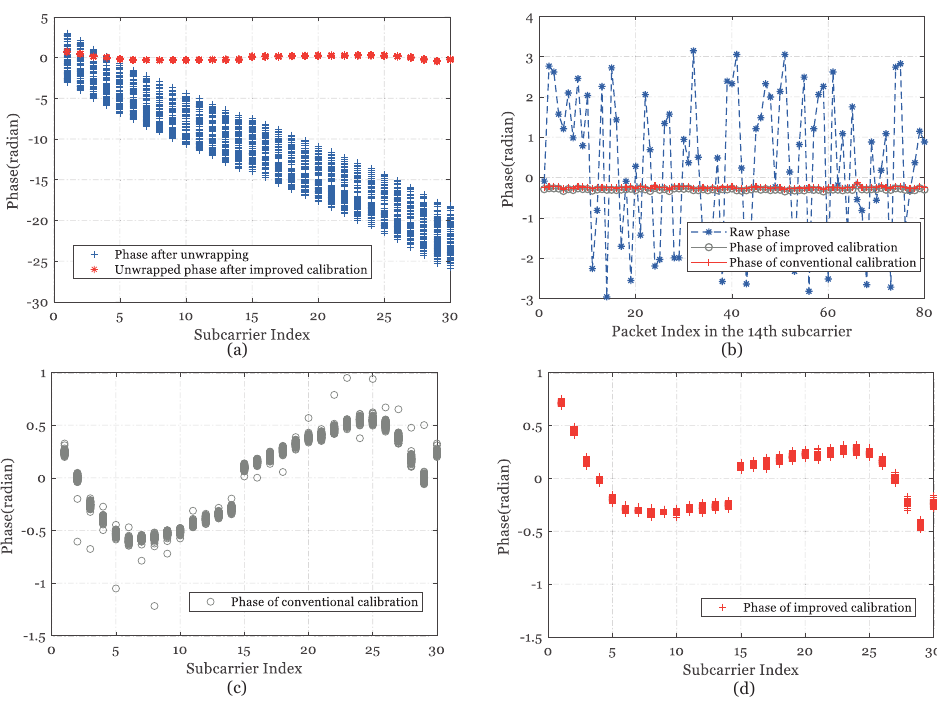
Figure 6. CSI phase calibration at LOS position. ( a ) CSI phase in one antenna. ( b ) CSI phase after linear transformation in the first subcarrier. ( c ) CSI phase after conventional calibration. ( d ) CSI phase after modified calibration.